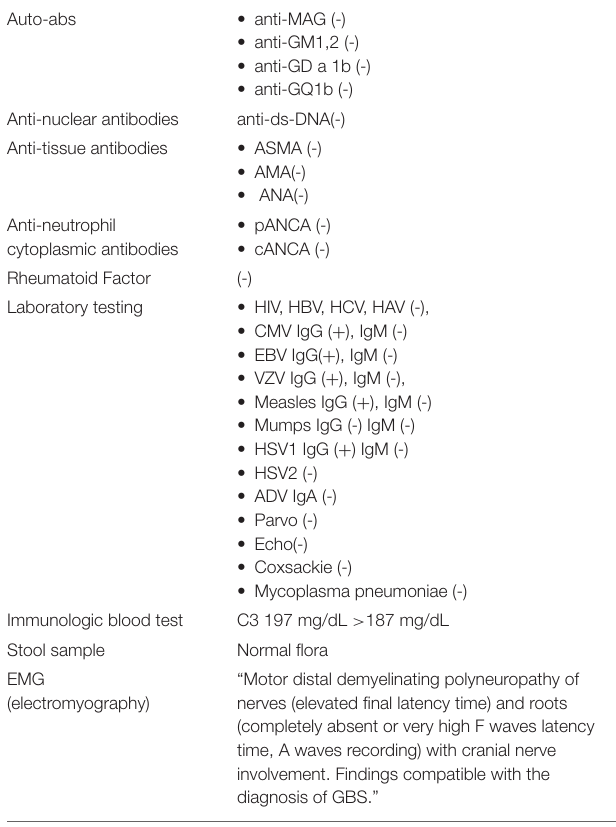
TABLE 2 | Patient’s medical information.